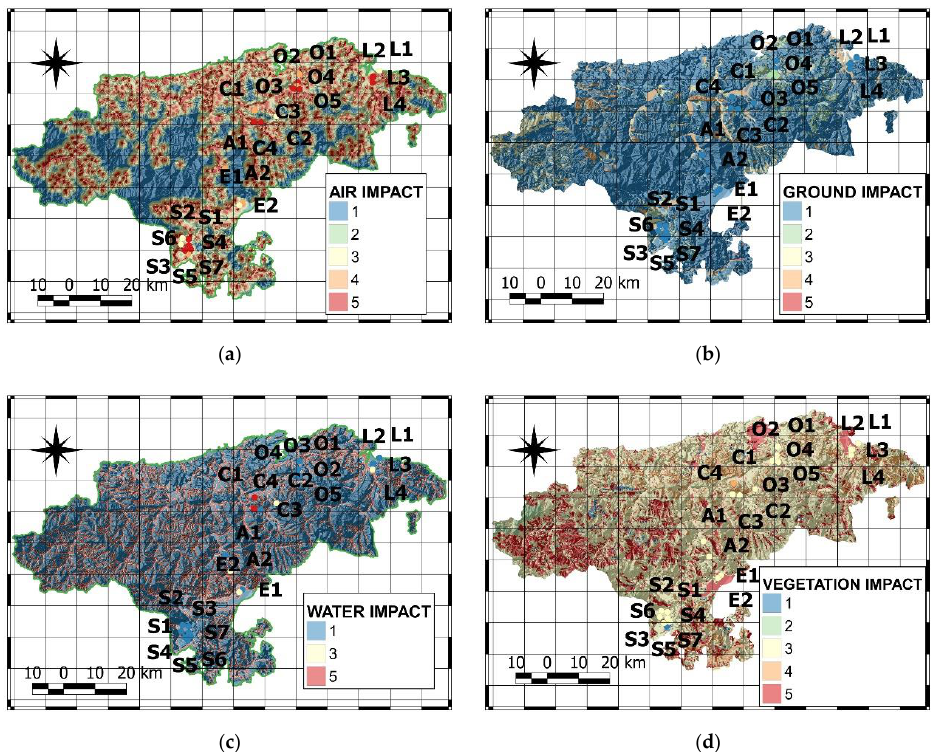
Figure 2. Maps of impacts according to components: ( a ) air, ( b ) ground-soil, ( c ) water and ( d ) vegetation. Table 10. Values of the weighting coefficient and the environmental impact of each component.